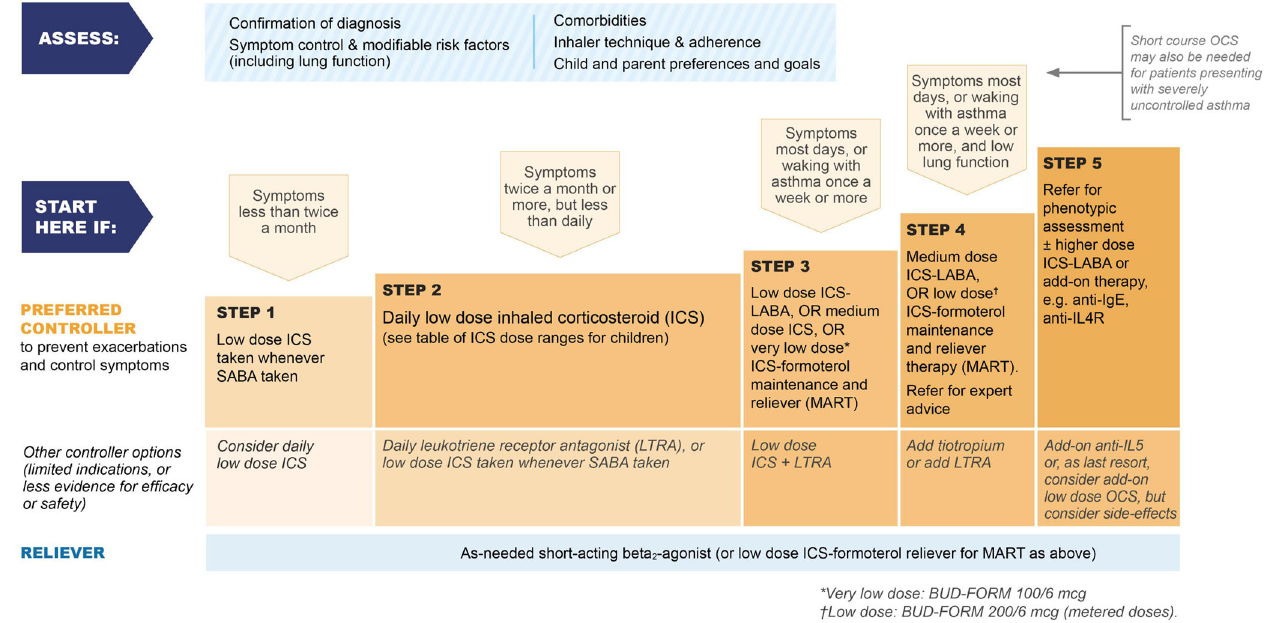
Fig. 6 Initial medications for children aged 6 – 11 years diagnosed with asthma. BUD-FORM budesonide – formoterol, ICS inhaled corticosteroid, LABA long-acting beta 2 agonist, LTRA leukotriene receptor antagonist, MART maintenance and reliever therapy with ICS – formoterol, OCS oral corticosteroids, SABA short-acting beta 2 agonist. Initial treatment for children aged 6 – 11 years diagnosed with asthma, with guidance on initial levels of medication for each treatment track based on symptoms and lung function where appropriate. Source: Box 3 – 4Di in GINA report 2022. Refer to the GINA report for other treatment components, including treatment of modi fi able risk factors and comorbidities, non-pharmacologic strategies, and education and skills training. Reproduced with permission from ref. 11